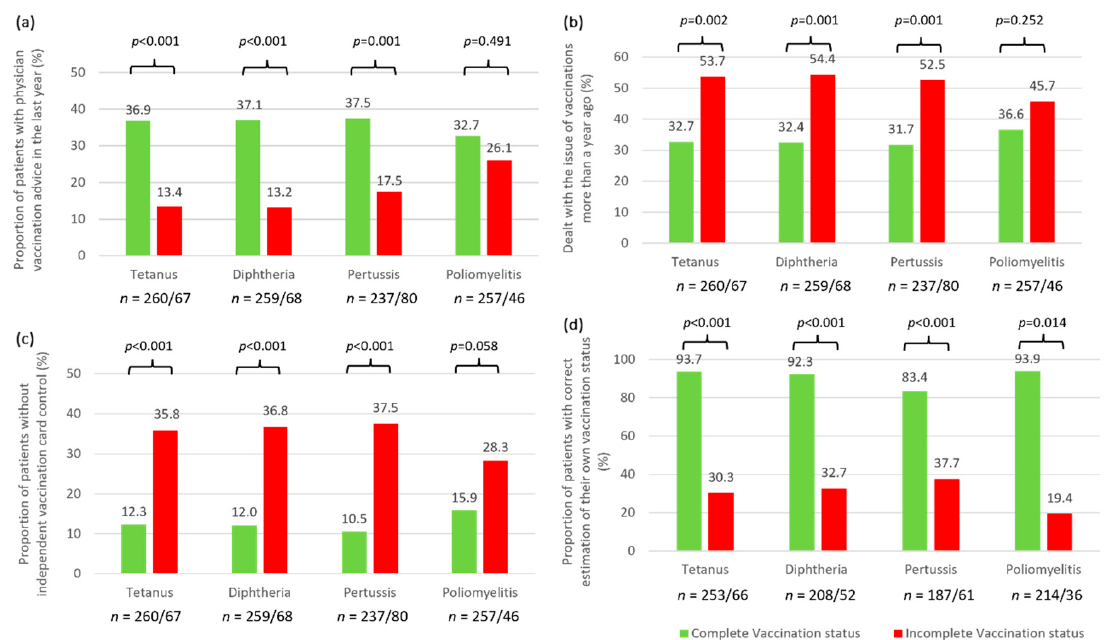
Figure 2. Comparison of MS patients with complete vs. incomplete vaccination status with regard to vaccination advice, interest, control and knowledge. ( a ) The proportion of patients with physician counseling on vaccination within the past year was generally lower among PwIV than among PwCV. ( b ) A higher proportion of PwIV did not deal with the issue of vaccinations during the past year. ( c ) Comparing the two groups in terms of general vaccination card control, the proportion of patients whose vaccination card was not regularly checked by anyone was markedly higher among PwIV. These differences were significant for all vaccinations ( p < 0.001 Fi ), except for polio vaccina- tion. ( d ) Concerning patients’ knowledge of their own vaccination status, the proportion of patients who correctly estimated it was significantly lower for PwIV compared to PwCV ( p ≤ 0.014 Fi ). Fi —